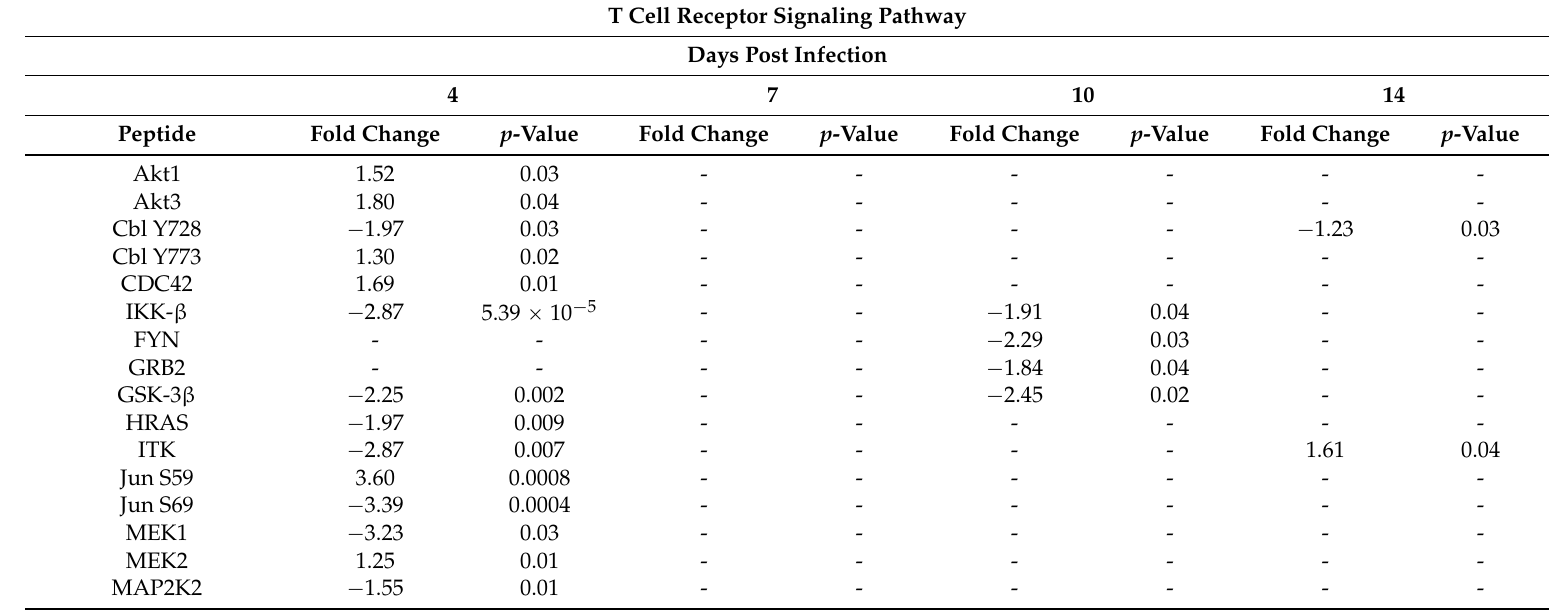
Table 4. Peptides from the T cell receptor signaling pathway that displayed a statistically significant change in